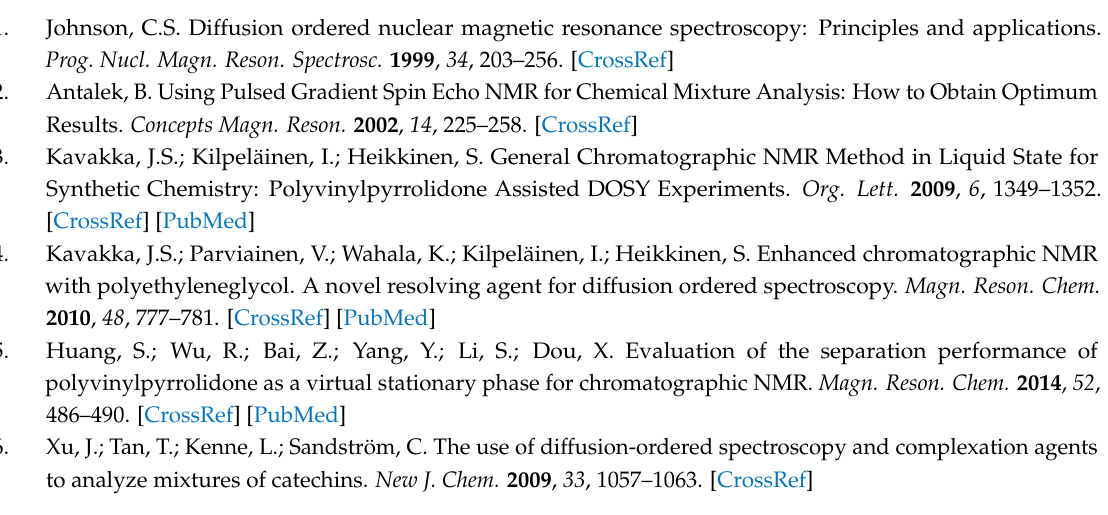
Figure S1. DOSY spectrum of a 10 mM α -arbutin and 10 mM β -arbutin mixture in D 2 O at 30 ◦ C, Figure S2. DOSY spectrum of 20 mM ( 13 C 6 )Glc in D 2 O at 30 ◦ C, Figure S3. DOSY spectrum of 20 mM Gal in D 2 O at 30 ◦ C, Figure S4. DOSY spectrum of 20 mM Man in D 2 O at 30 ◦ C, Figure S5. DOSY spectrum of 20 mM Cello in D 2 O at 30 ◦ C, Figure S6. DOSY spectrum of a 10 mM α -PhGlc and 10 mM α -arbutin mixture in D 2 O at 30 ◦ C, Figure S7. DOSY spectrum of a 10 mM β -arbutin and 10 mM β - p NPGlc mixture in D 2 O at 30 ◦